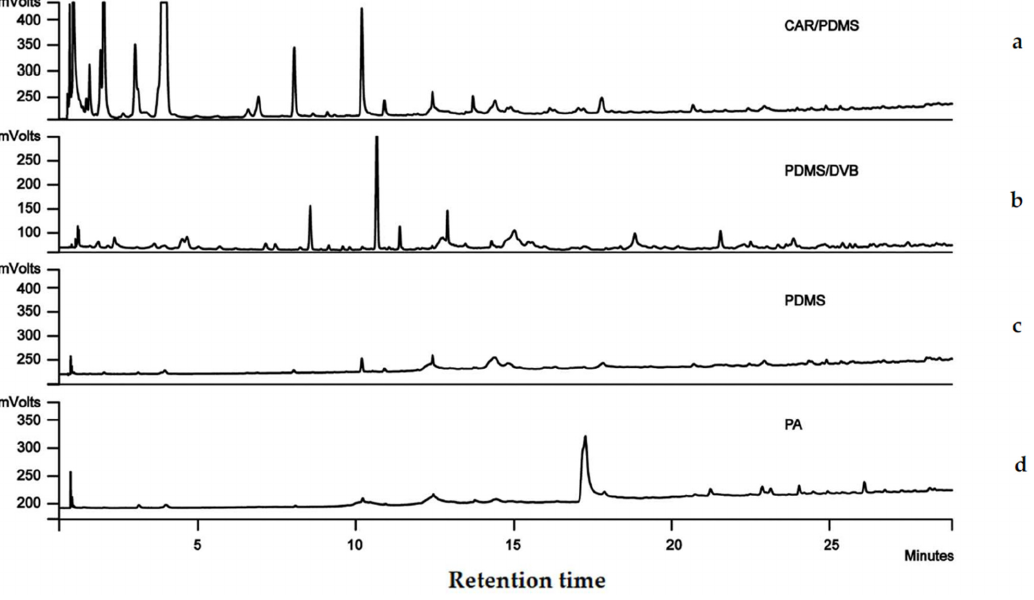
Figure 1. Comparison of different fibres. GC-FID chromatograms of headspace volatiles from wheat extracted using ( a ) CAR/PDMS; ( b ) PDMS/DVB; ( c ) PDMS; and ( d ) PA SPME-type fibres.